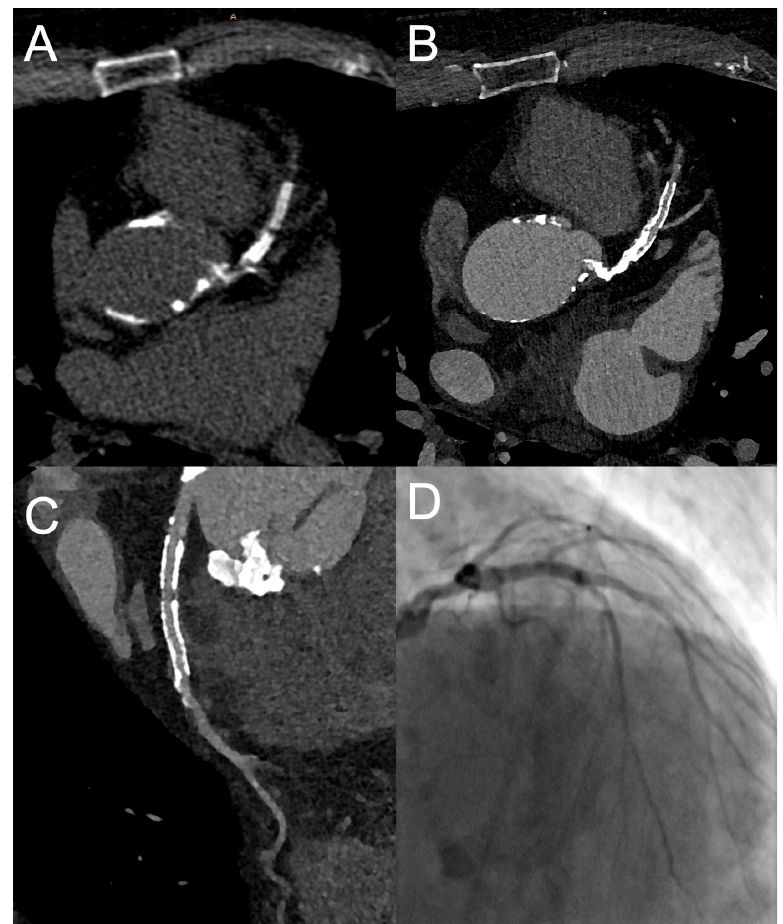
Figure 2. ECG-gated ultra-high-resolution cCTA of the heart using photon-counting. Images show the heart of a 79-year-old male patient referred for preprocedural planning of a transcatheter aortic valve replacement. Despite extensive calcifications (Agatston score of 3388) and two coronary stents in the LAD, a visualization of the coronary arteries was possible. ( A ): unenhanced coronary calcium scoring CT, axial reconstructions with a slice thickness of 2.0 mm using the Br36 kernel. ( B ): ultra- high-resolution cCTA, axial reconstructions with a slice thickness of 0.4 mm and an increment of 0.2 mm using the kernel Bv56 and moderate iteration Q3. ( C ): Curved multi-planar reconstruction of the LAD. An in-stent stenosis can be ruled out. ( D ): Invasive coronary angiography of the LAD confirming the CT findings. Courtesy of Christopher L. Schlett, University of Freiburg,